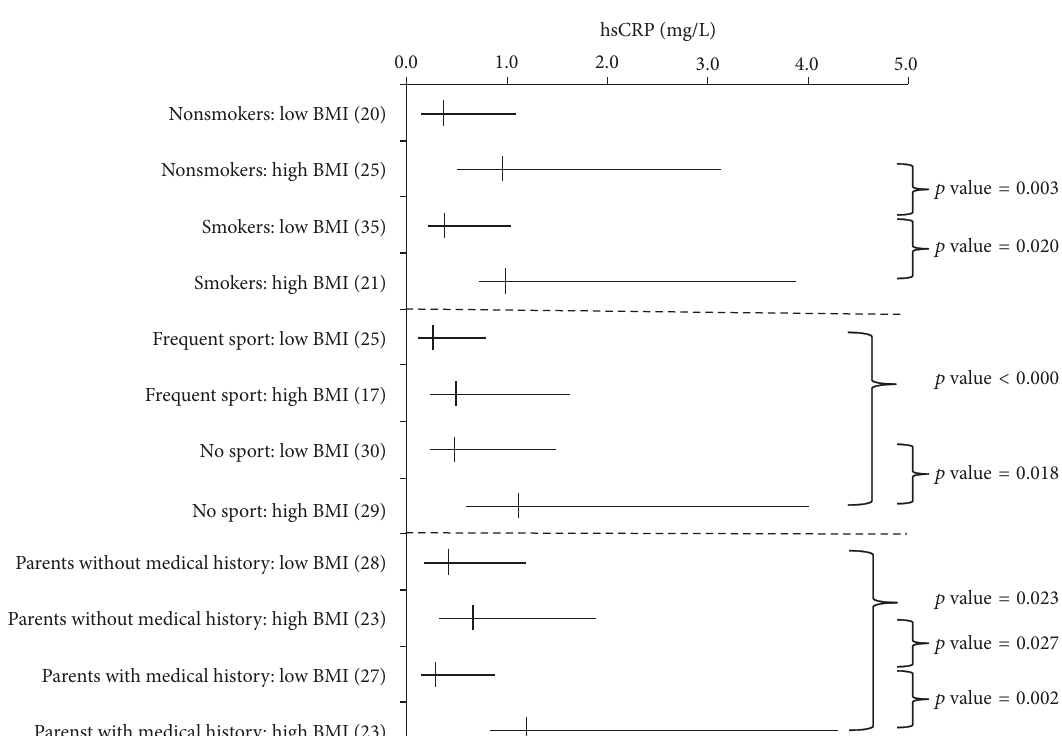
Figure 1: To investigate the effect of the participant’s BMI along with smoking, sports practicing, and the presence of medical history in one of the participant’s parents on hsCRP levels, each group of participants was separated, according to their BMI levels, into two groups. Vertical lines denote the median; horizontal lines represent participant’s group enclosed in interquartile range. Wilcoxon rank sum test of significance difference ( 𝑝 value) was applied between different pairs of groups and only 𝑝 values < 0.05 were